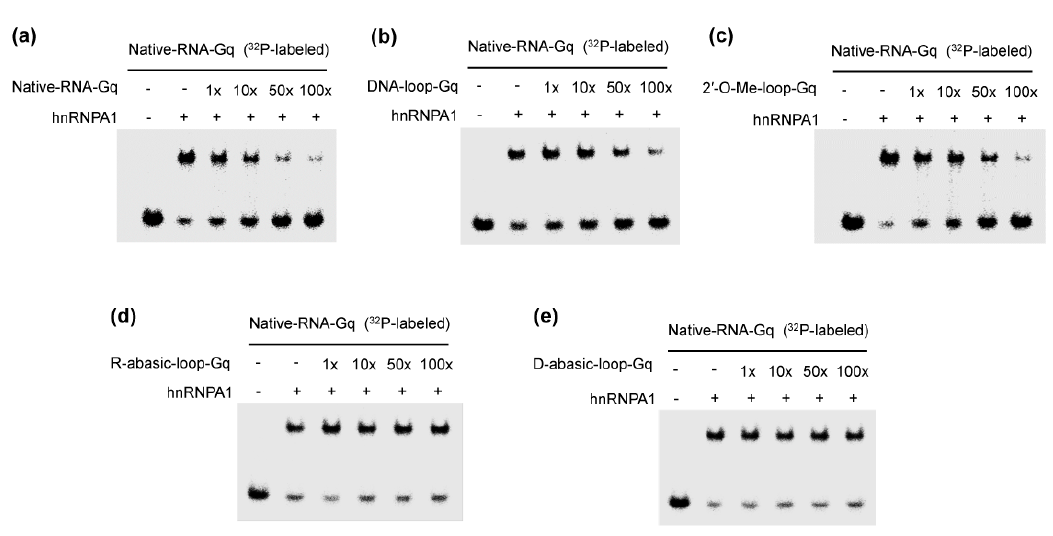
Figure 2. Competitive binding of the complex of heterogeneous nuclear ribonucleoprotein A1 (hnRNPA1) and G-quadruplex with various oligonucleotides: natural telomere RNA (Native-RNA-Gq) ( a ); DNA loop (DNA-loop-Gq) ( b ); 2 ′ -O-methyl ribonucleotide (2 ′ -O-Me-loop-Gq) ( c ); the abasic RNA loop (R-abasic-loop-Gq) ( d ); and the abasic DNA loop (D-abasic-loop-Gq) ( e ). Ratios indicated on the upper. RNA-protein complexes were resolved by 8% polyacrylamide gel electrophoresis and visualized by autoradiography.